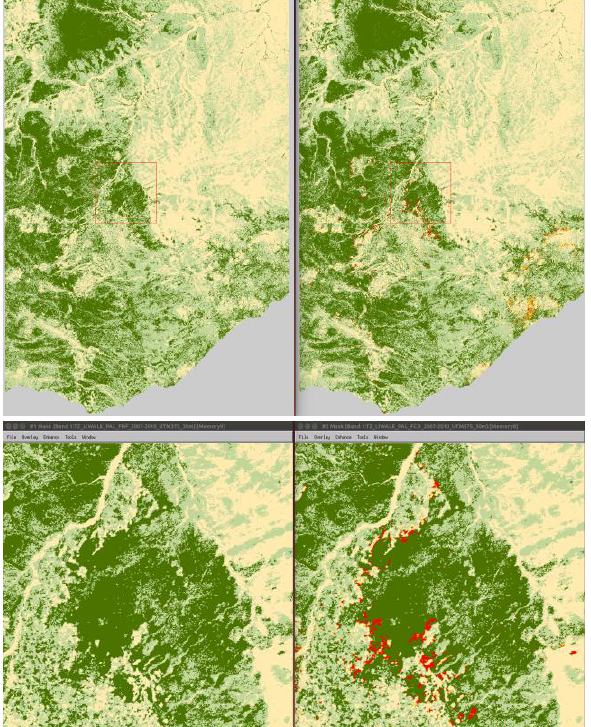
Figure 5. 2007 (left) and 2010 (right) ALOS Palsar mosaic. Rectangle enlargements in lower panel.